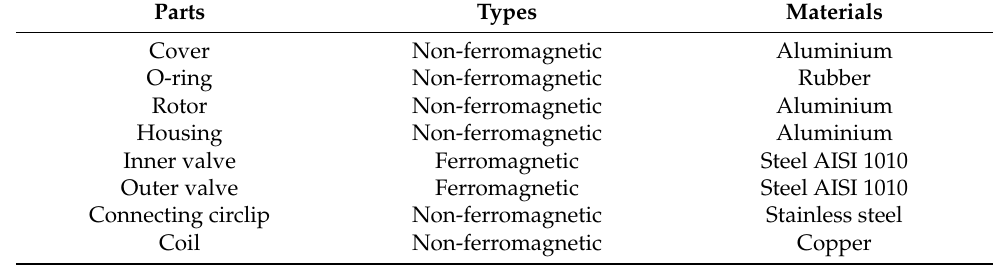
Figure 4. Static valve design configuration.